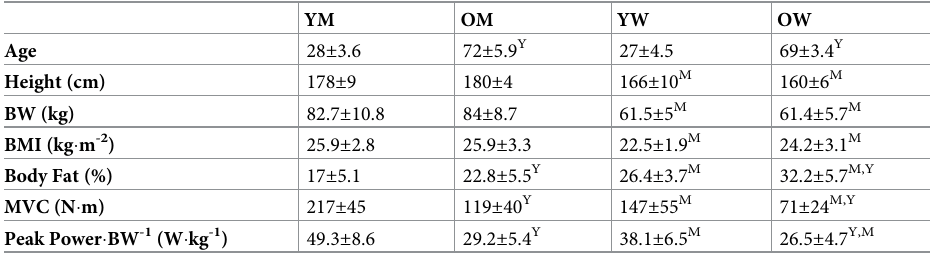
Table 1. Participant